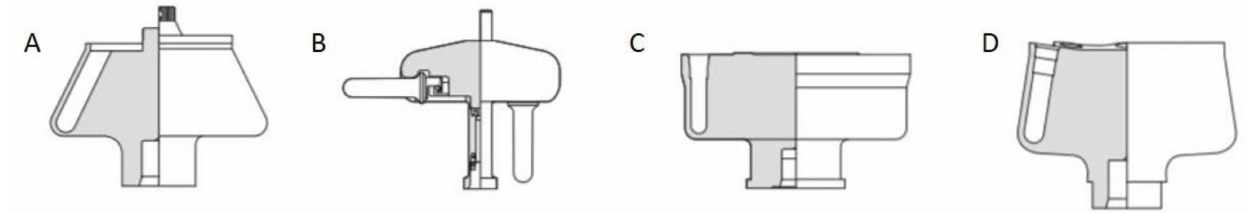
Figure 10. Four main types of rotors used in the preparative ultracentrifugation experiments, including ( A ) fixed-angle rotor, ( B ) swinging-bucket rotor, ( C ) vertical rotor and ( D ) near-vertical rotor. For the ordering of nanoparticles, a swinging-bucket rotor is recommended since all the nanoparticles can sediment horizontally towards the bottom of the tube, which is most comparable to an AUC cell. Reproduced with permission from [86], Copyright Beckman-Coulter,